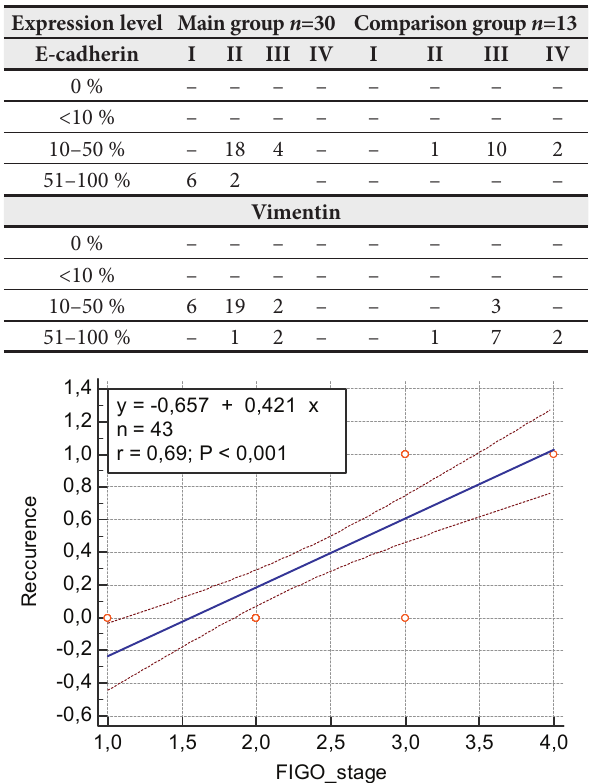
Distribution of tumors ( n =43) depending on the level of expression of IHC markers of EMT and the disease stage by FIGO